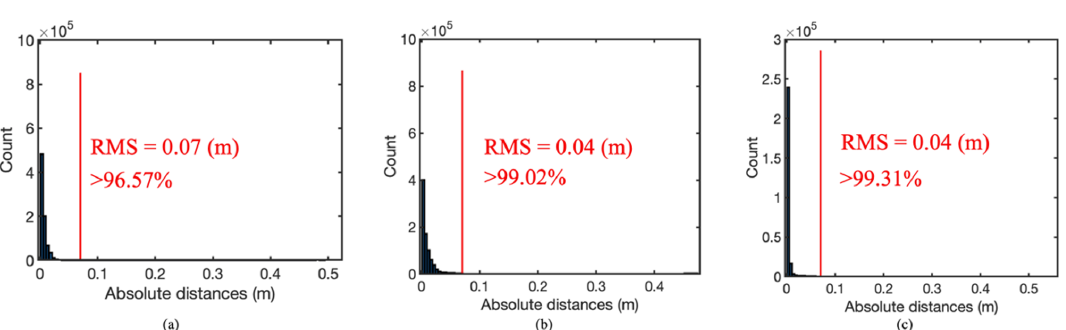
Figure 11. Comparative result of individual rooms with irregular shape; ( a – c ) show the mean error distribution of points for Office 16, WC 1, and Hallway 1 in Area 1/2D-3D-S.